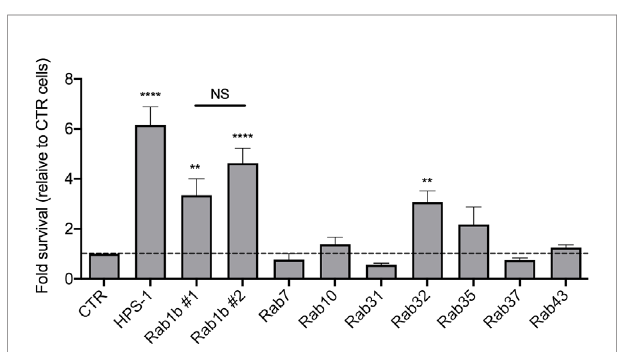
FIGURE 4 | Validation of candidate genes. For each gene, lentiviral particles were generated and used to transduced iBMDMs. After selection with 5 µg/ml puromycin for 48 hours, cells were infected with S . Typhi ::mCherry . At different times post- infection (1.5 and 24 hours), cells were lysed and CFUs enumerated. The CFUs obtained were normalized against 1.5 hpi and the data represent the fold-survival of the bacteria relative to in control (CTR) cells. Values are means ± SEM of at least two independent experiments performed in triplicates. P values were determined by the Student´s t test: ** P < 0.01 ; **** P < 0,001 . NS, non-signi fi